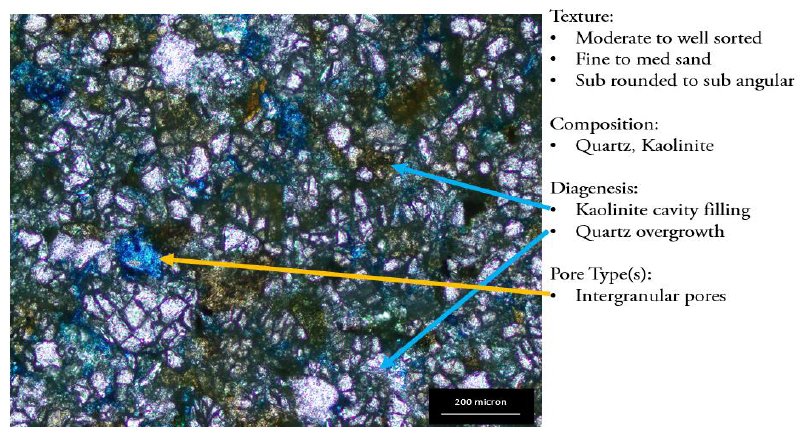
Figure 12. Textural and compositional features of L303 Temburong.